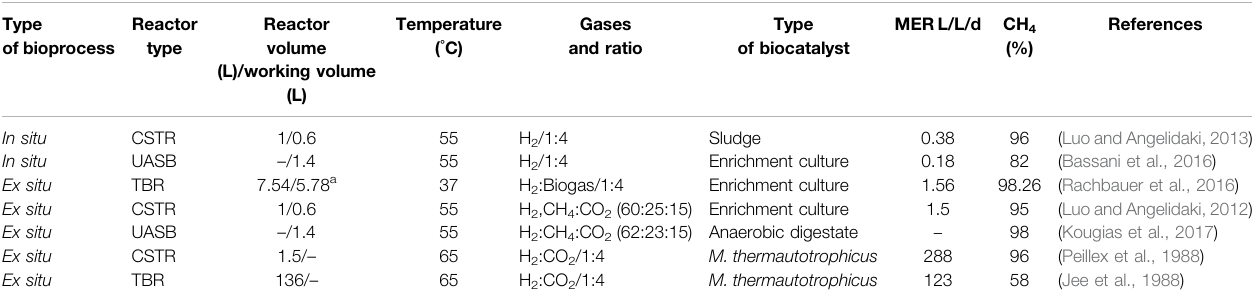
TABLE 2 | A comparison of in situ and ex situ biomethanation with different reactor setups. Type Reactor of bioprocess